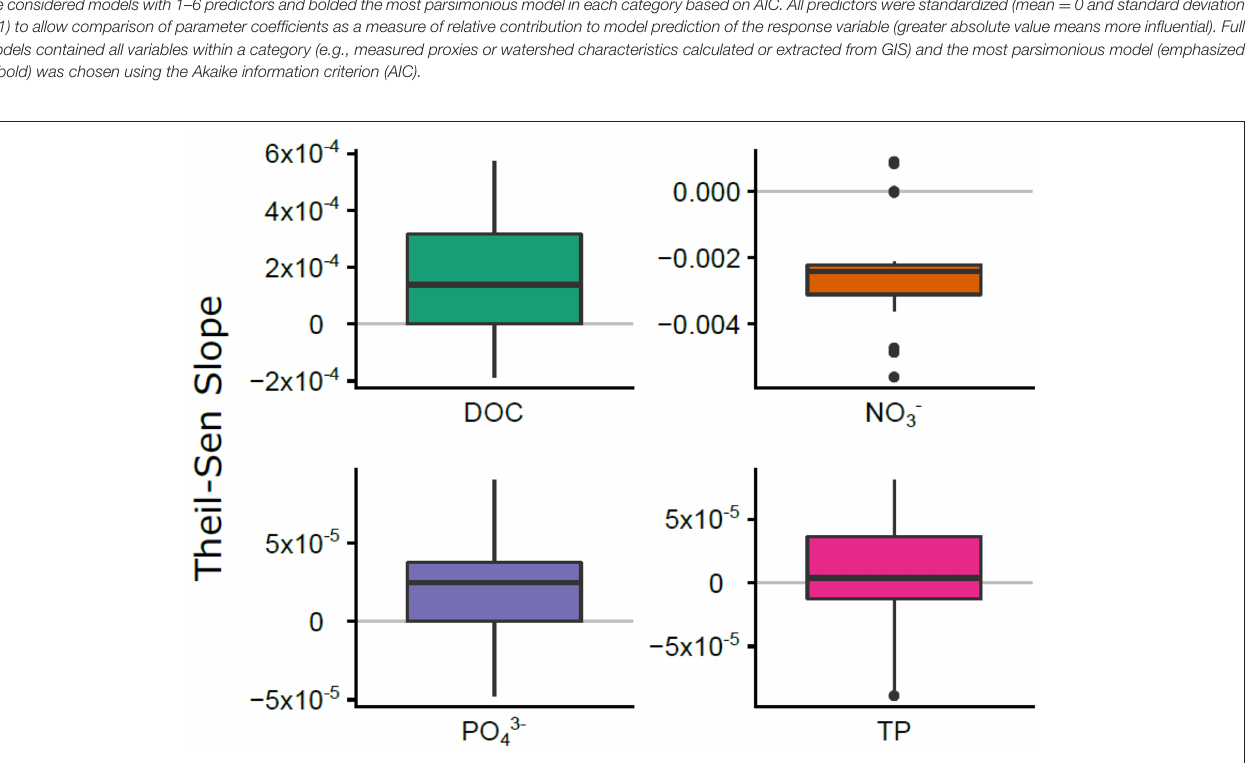
4 (0.17–0.69 kg P ha − 1 yr − 1 ) and were negatively